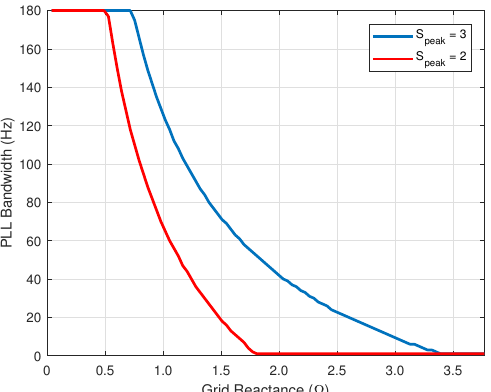
Figure 6. PLL bandwidths which satisfy maximum-peak criterion (MPC) as a function of grid reactance.